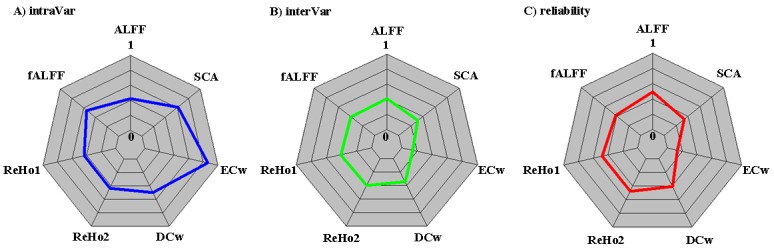
Quantification of variability of seven common rfMRI metrics across the whole cortical mantle.A) Auantification measures of intra-individual variability strength are plotted in polar form for amplitude of low-frequency fluctuations (ALFF), fractional ALFF (fALFF), regional homogeneity with length-one (ReHo1) and length-two (ReHo2) neighbors, seed-based connectivity analysis (SCA), weighted degree centrality (DCw) and eigenvector centrality (ECw). B) Auantification measures of inter-individual variability strength are plotted in polar form for the rfMRI metrics. C) Auantification measures of test-retest reliability strength are plotted in polar form for the rfMRI metrics. Note that for the purpose of visualization, all the strengths are normalized into a standard value between 0 and 1 by dividing the specific variance with the overall variance.